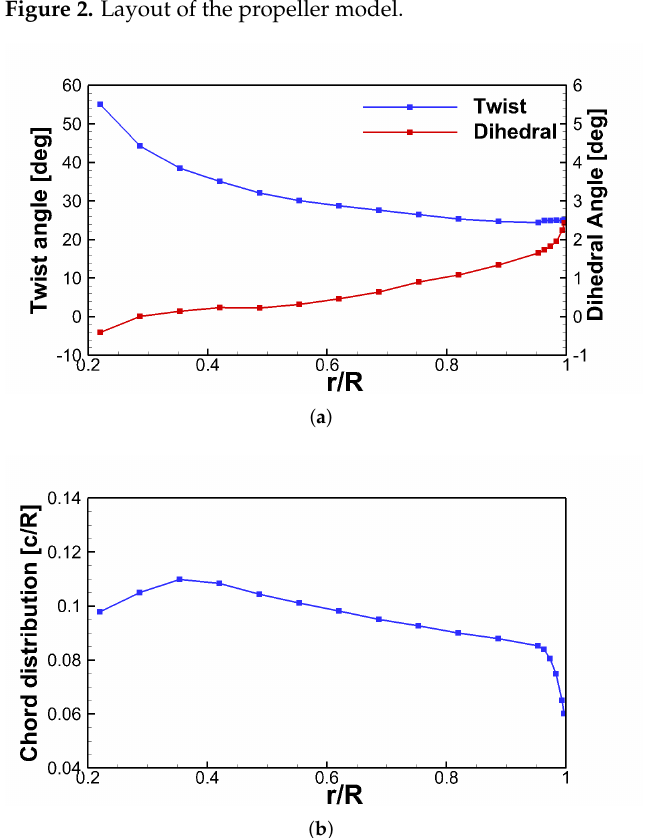
Figure 3. ( a ) Twist, dihedral angle, and ( b ) chord distributions of the Varioprop 12C propeller blade along the spanwise radial